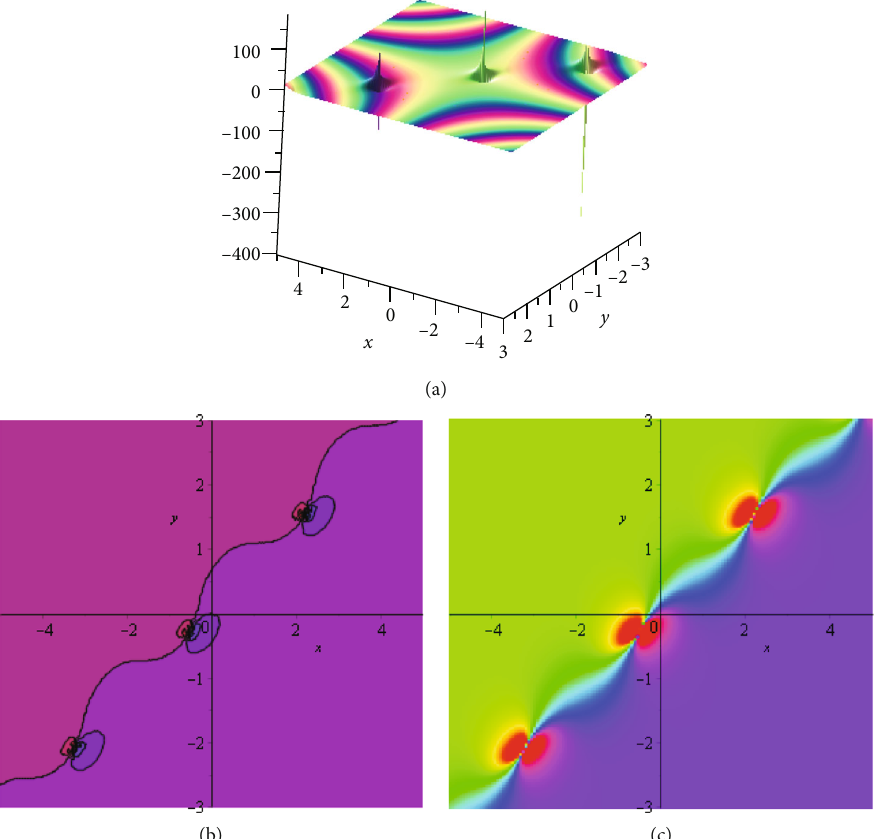
= : 5, a = 1 : 5, a = 2, a = 1, Ω = 1 : 1, Ω = 1 : 5, Ω = 1 : 2, δ = 1, δ = 1 2 3 4 1 2 4 1 2